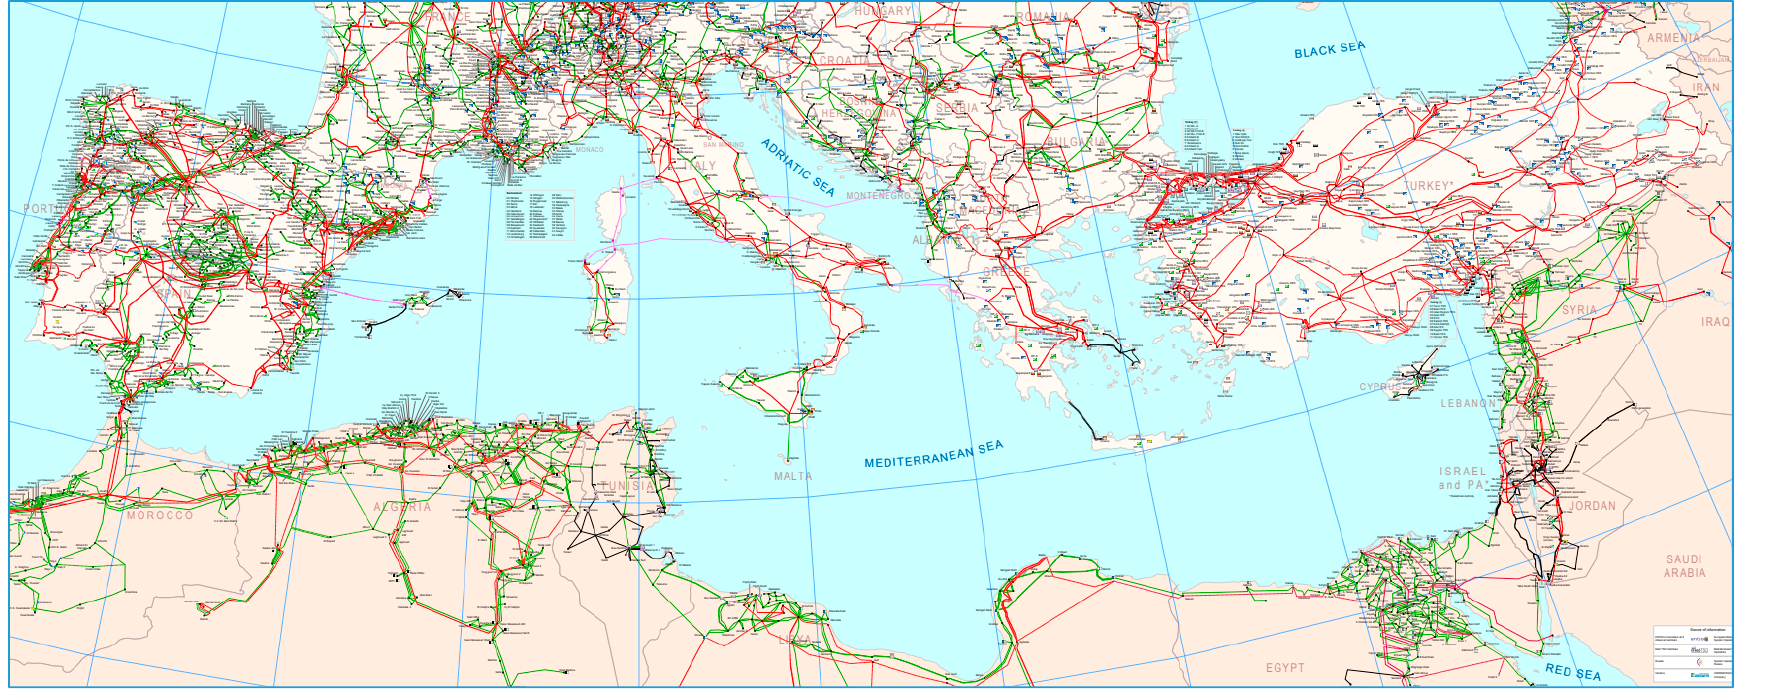
Figure 1. Joint ENTSO-e and Med-TSO map snapshot of the current transmission grids in the Mediterranean area [Source: ENTSO-e web-site].